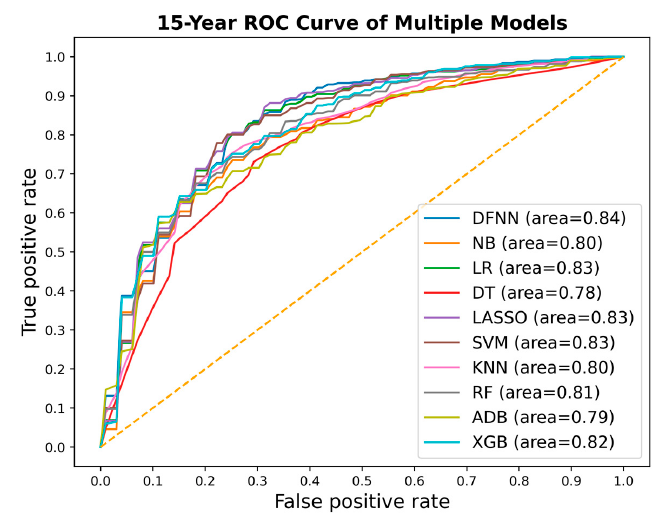
Figure 4. ROC curves of the best-performing models for all methods, each respectively, for predicting